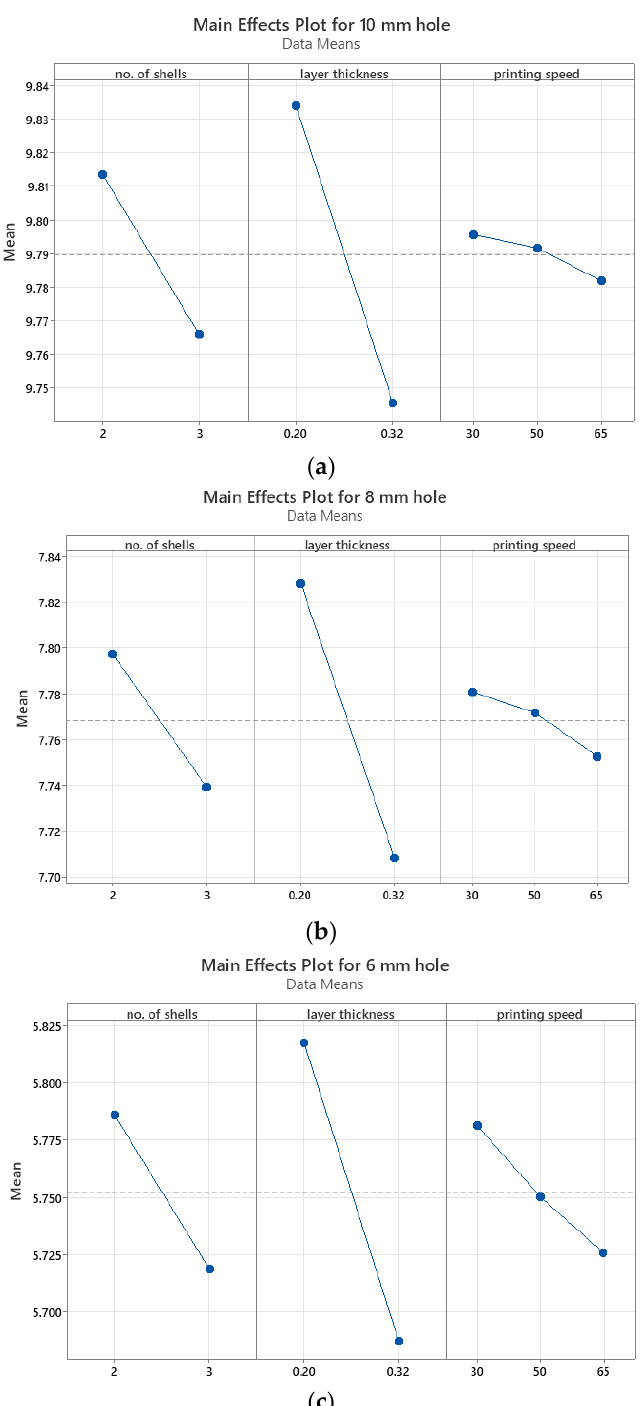
Figure 4. Main effect plots for the holes dimensional accuracy: ( a ) 10 mm holes; ( b ) 6 mm holes; ( c ) 8 mm holes.